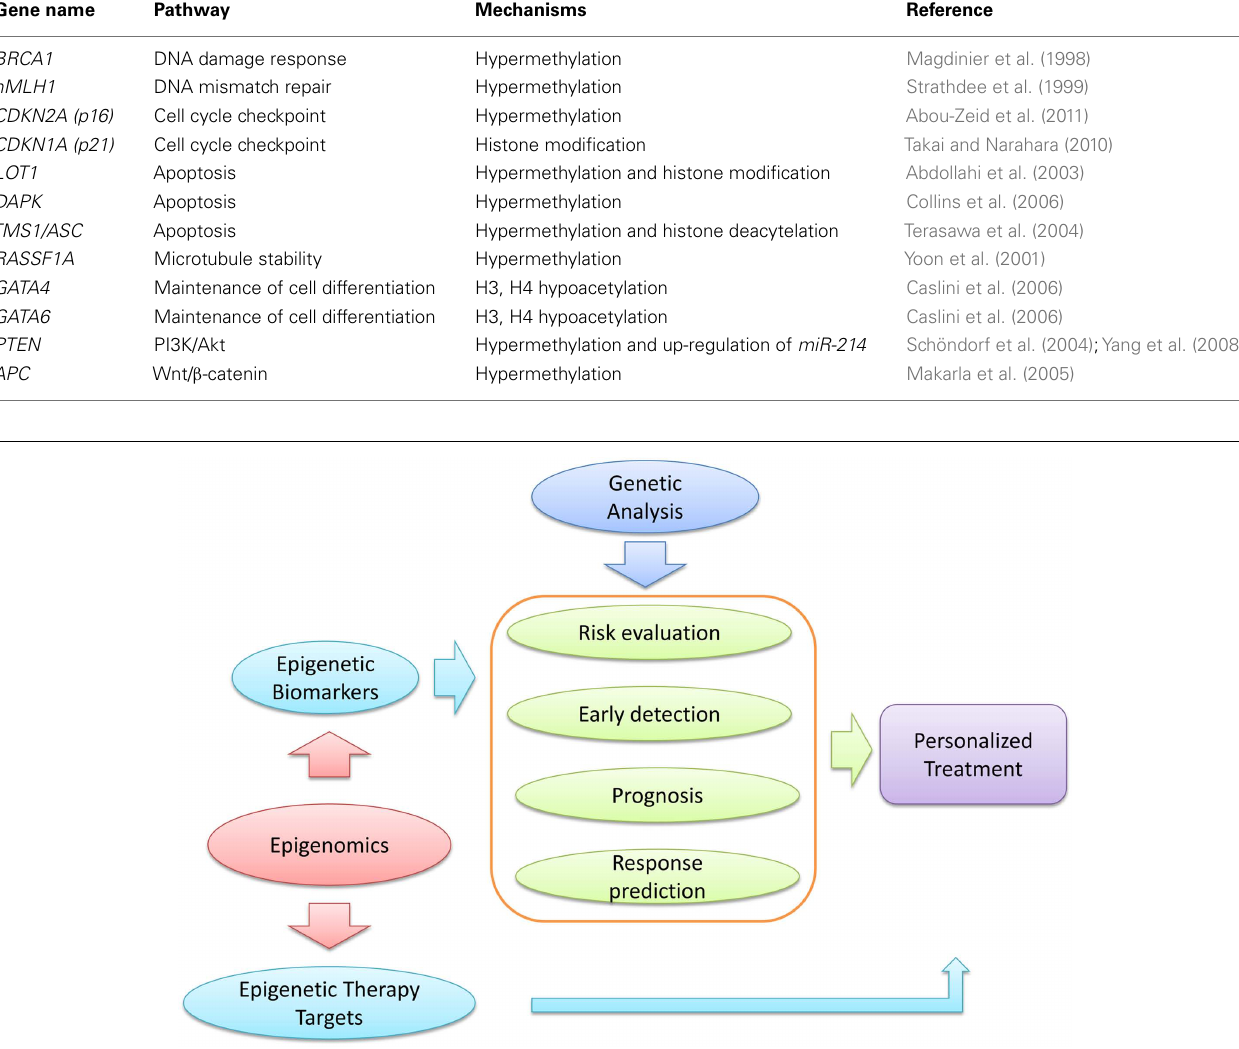
FIGURE 1 | Function of epigenomic studies in cancer prevention. Epigenomic analyses of cancer could provide novel epigenetic biomarkers which can serve for cancer risk evaluation, early detection, prognosis, and chemotherapy response prediction. Studies of this